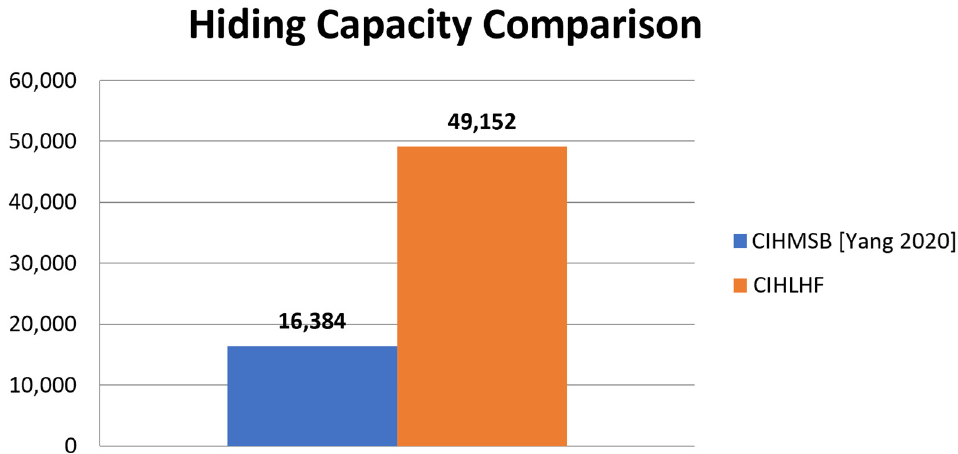
Figure 5. Hiding capacity graph (unit is (bits × carrirer − 1 )).